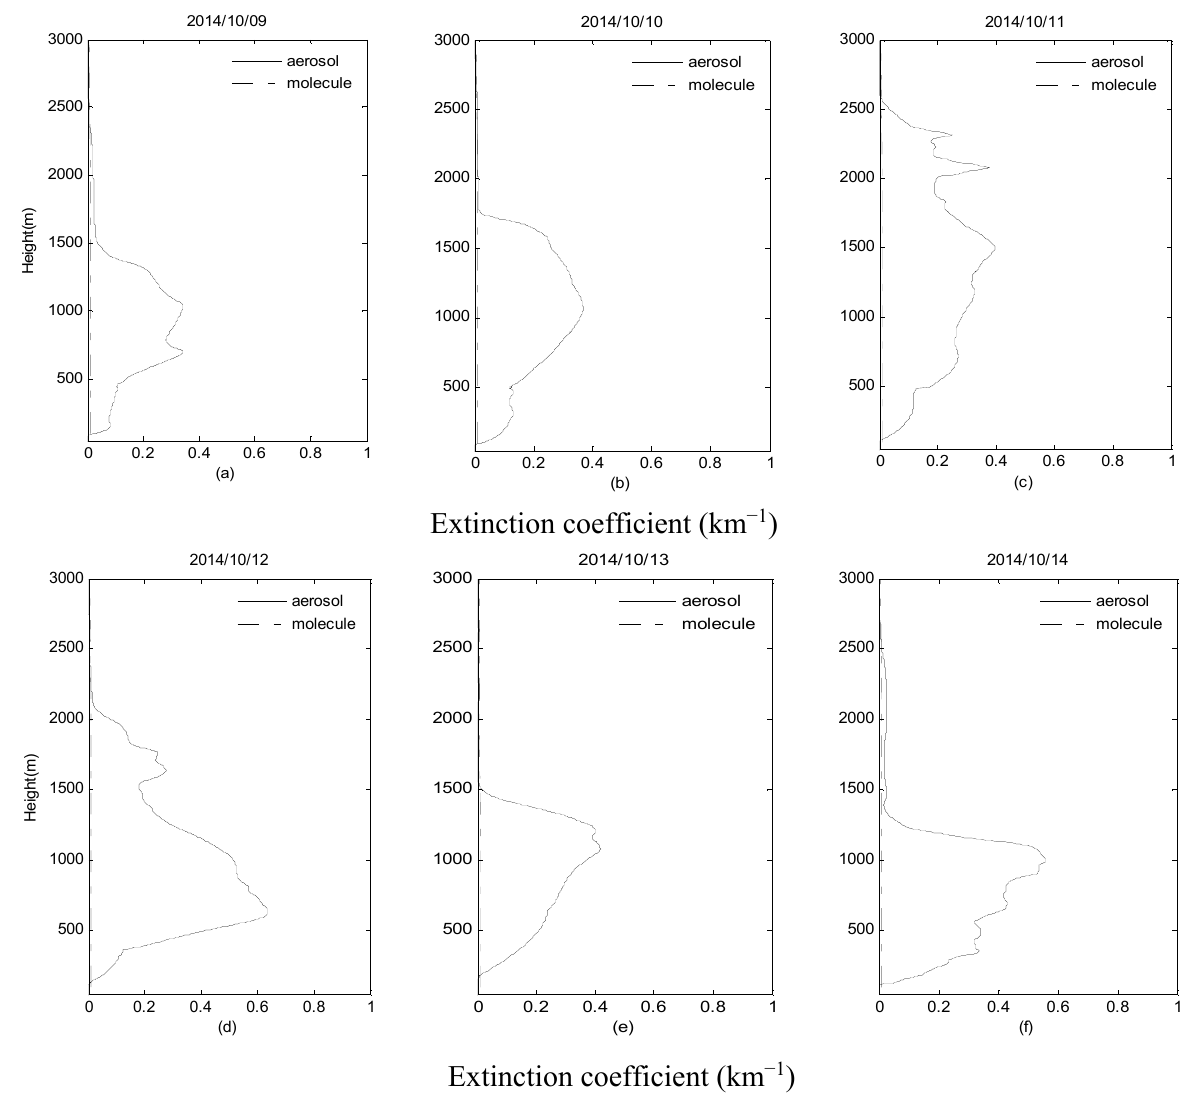
Figure 5. Extinction coefficient profiles for a typical haze event on 9–14 October 2014: ( a ) 9 October, ( b ) 10 October, ( c ) 11 October, ( d ) 12 October, ( e ) 13 October, and ( f ) 14 October. The solid lines represent the atmospheric aerosol extinction coefficient, while the dotted lines represent the atmospheric molecule extinction